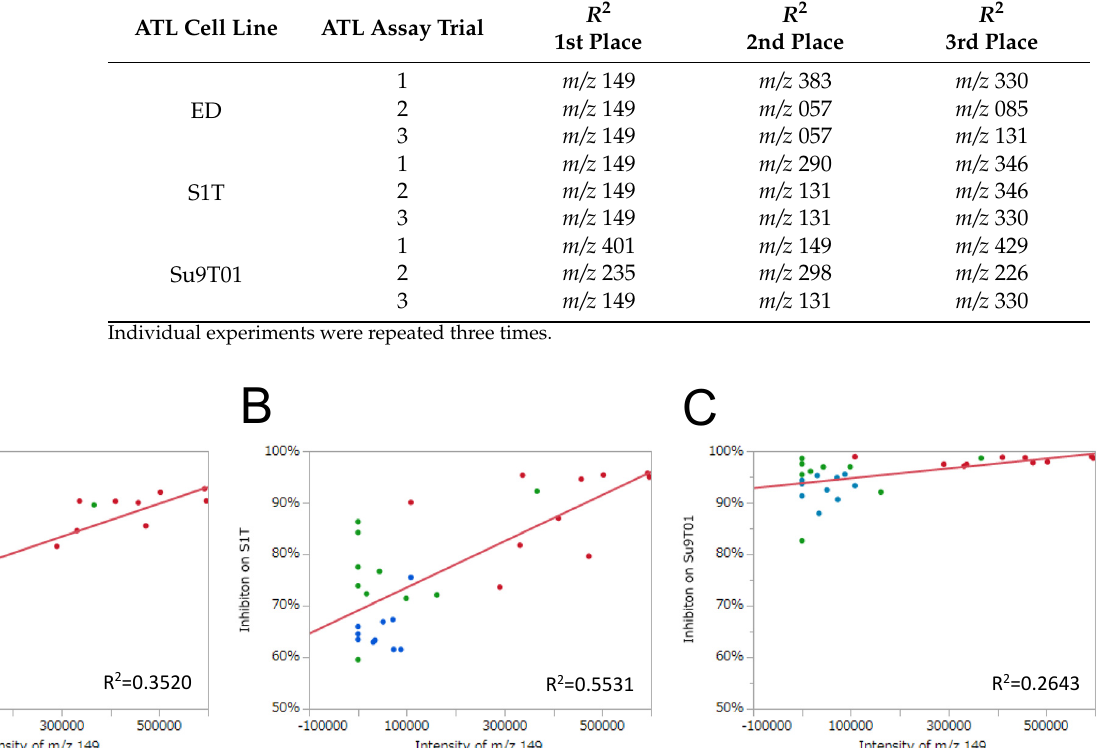
Table 2. The regression coefficient ( R 2 ) values for linear regression analysis of the prediction of ATL inhibitory activity using DI-EI-MS metabolomics. ATL Cell Line